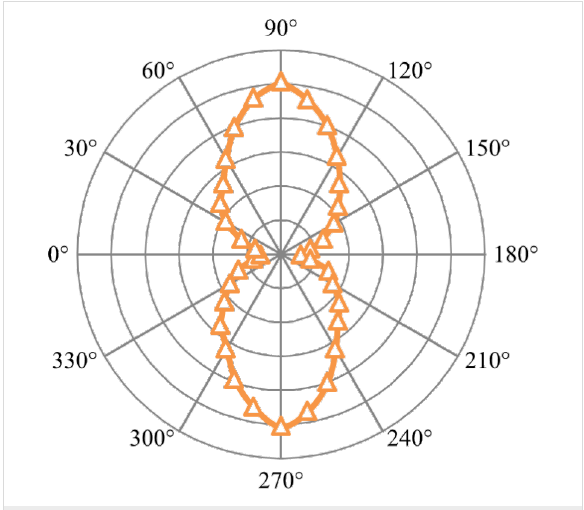
Figure 5: Polar plot for plasmons on 20 µm long stripe waveguide excited via grating coupling. Radial scale goes from 0 to